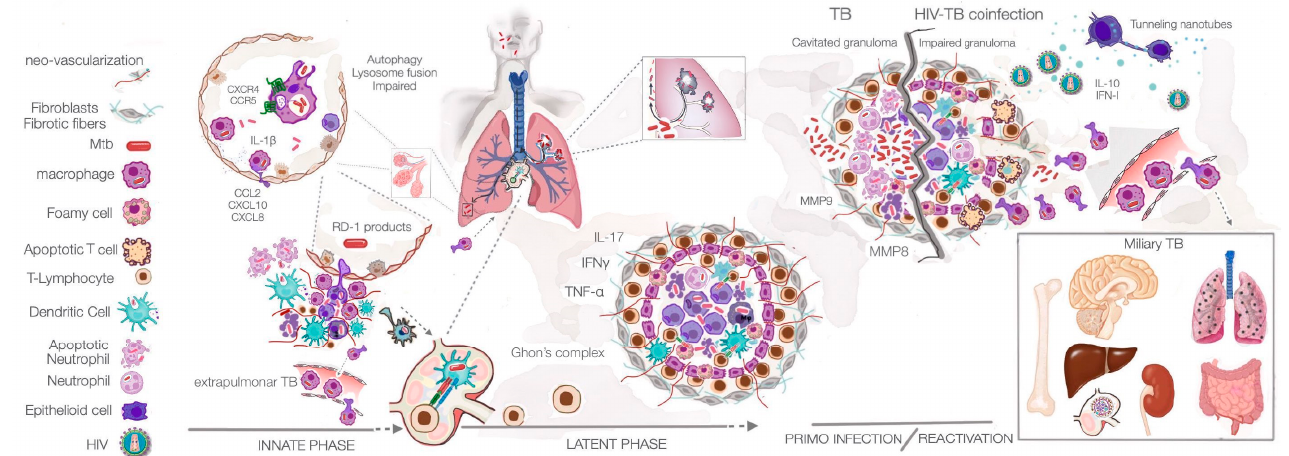
Figure 1. Pathogenesis of Mtb infection: implications in HIV co ‐ infection. Inhaled aerosols containing up to three bacilli reach the alveoli in the lower part of the lung. Macrophages take up the pathogen, but Mtb impairs phagolysosome fusion and autophagy. This is enhanced during HIV co ‐ infection, which helps Mtb to establish intracellular niches. In turn, Mtb increases the expression of the HIV coreceptors CXCR4 and CCR5 (helping HIV spread during coinfection). The secretion of IL ‐ 1 β by infected macrophages and pneumocytes induces transmigration to the lung tissue. Mtb RD ‐ 1 products, together with chemokines secreted by infected macrophages, a tt ract more innate cells, leading to the formation of the innate granuloma. If this response is strong, the infection is contained and, in 95% of people, it progresses to a latent phase. In about 5% of people, this phase leads to primary infection with pleural extrusion and eventual haematogenous dissemination. The latent granuloma is maintained by newly arrived T lymphocytes (after proper priming by dendritic cells in the mediastinal lymph nodes) and macrophages, providing a proper balance of cytokines (i.e., TNF ‐α , IFN γ , and IL ‐ 17). In a few granulomas (usually in the upper part of the lung), the pathogen may go into a low metabolic state of dormancy. Immunosuppressive conditions, such as malnutrition or ageing, may favour reactivation (usually in the upper part of the lung). The cytokine balance is disturbed towards increasing levels of TNF ‐α , leading to excessive neutrophil recruitment with the secretion of metalloproteinases (MMPs) and the caseation of the granuloma. Ultimately, after tissue cavitation, bacteria are released for transmission to new hosts. In the presence of HIV co ‐ infection, extensive lymphocyte depletion, and low secretion of TNF ‐α , the granuloma dynamics and integrity are compromised. The environment of cytokines secreted by deactivated macrophages (e.g., IL ‐ 10 and IFN ‐ I) will favour the formation of tunnelling nanotubes and the cell ‐ to ‐ cell spread of HIV throughout the body. We postulate that HIV ‐ infected cells, or those under the in fl uence of the viral Nef protein, will facilitate macrophage migration to other tissues, thereby contributing to the spread of Mtb and extrapulmonary TB.